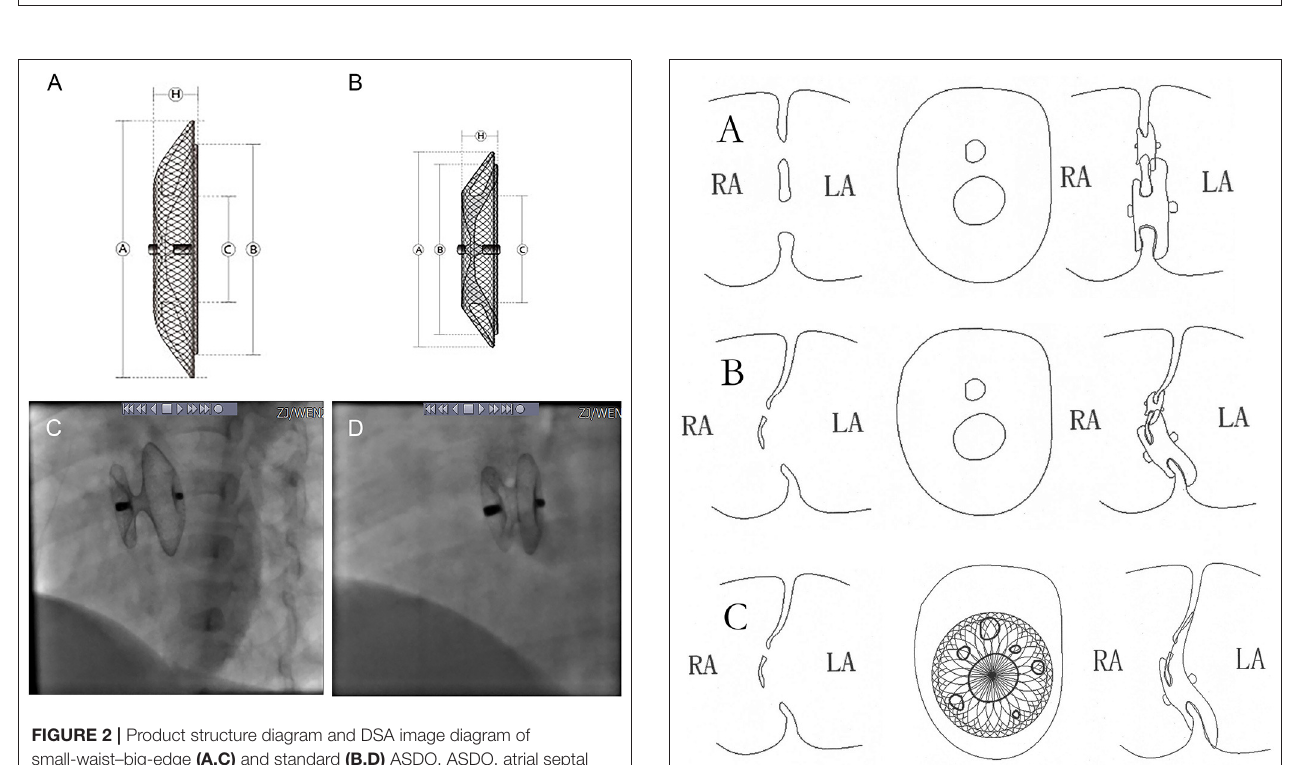
FIGURE 1 | The classification standard of all patients. ASD, atrial septal defect; IDD, interdefect distance; ASA, atrial septal aneurysm.